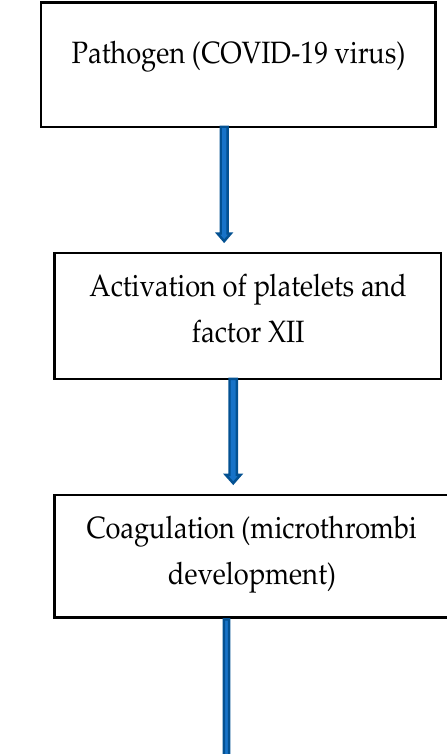
Figure 6. The possible mechanisms involved in the development of COVID ‐ 19 cardiovascular com ‐ plications.